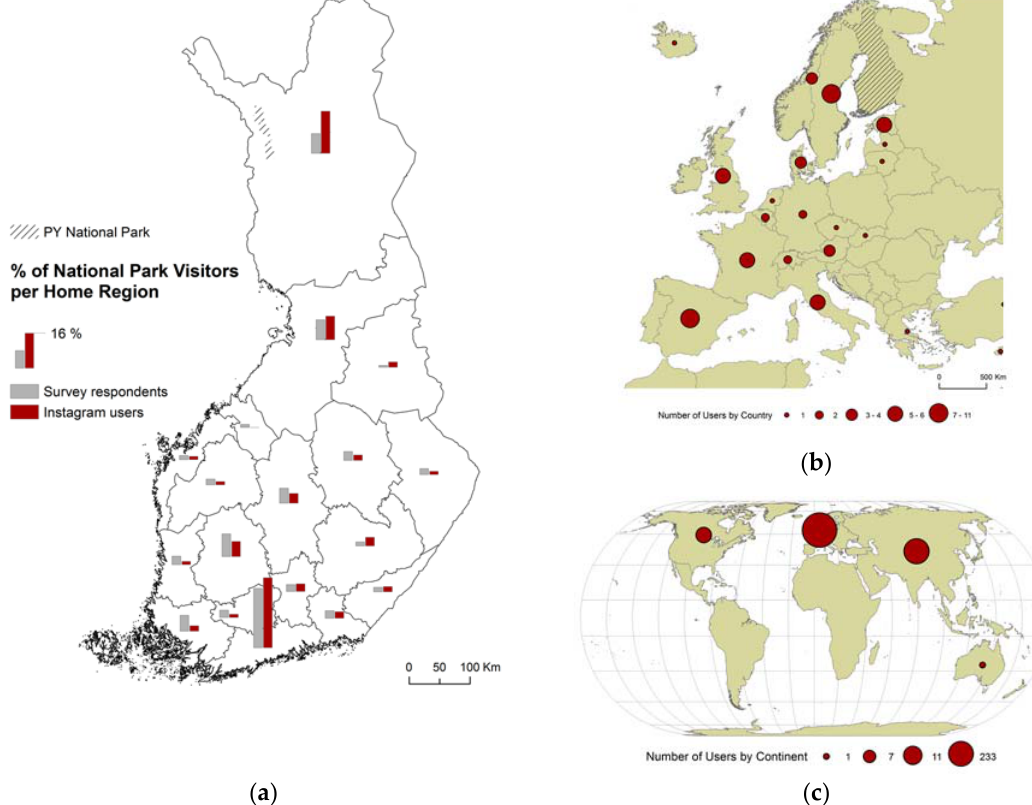
Figure 6. ( a ) Proportion of surveyed home locations (grey) and potential home locations observed from social media (dark red) by region in Finland; ( b ) Number of Instagram users per country and ( c ) per continent from which they had posted most pictures from.